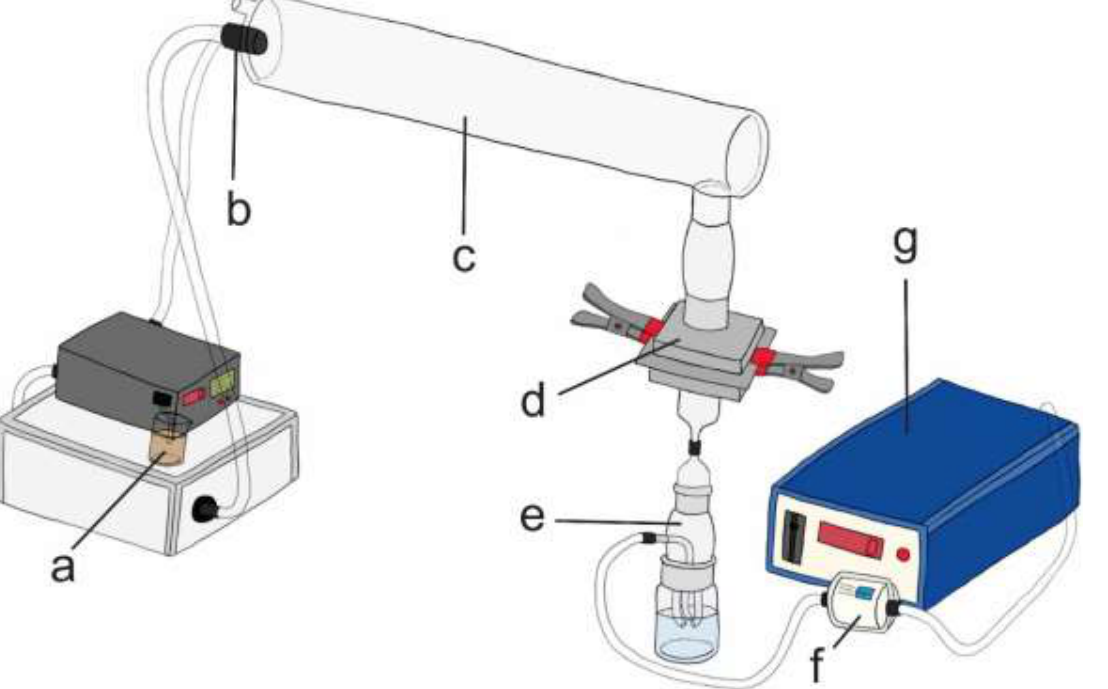
Figure 2. Experimental setup for determination of bacterial and viral filtration efficiency. Bacte- rial/viral sample (a), nebulizer (b), glass chamber (c), two-piece component into which the mask was tightly clamped (d), sampler (e; a representative impinger is shown in this figure, whereas we used two types of impinger or the Andersen sampler), HEPA filter (f) and the vacuum pump (g).